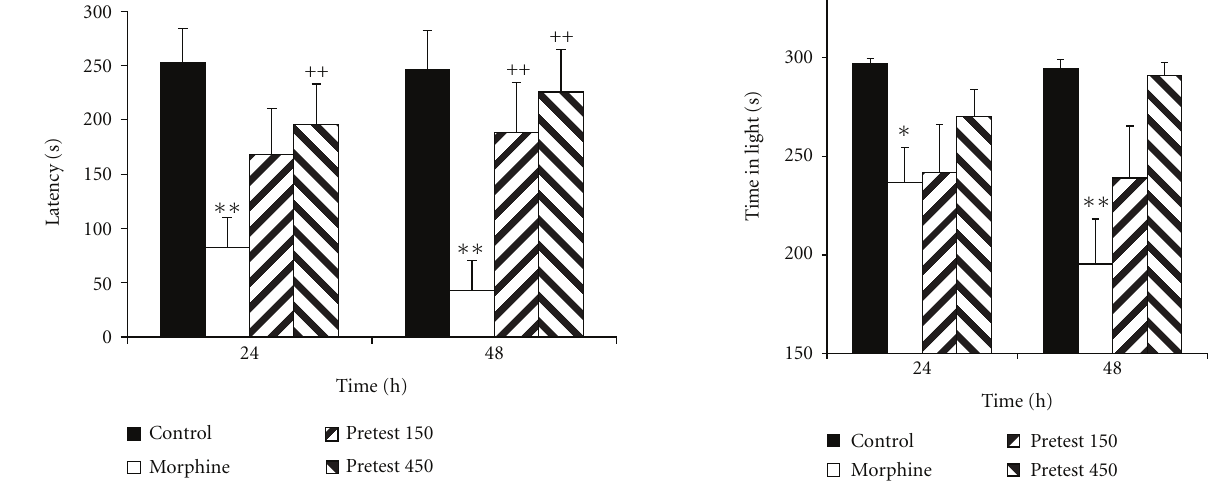
Figure 6: Comparison of the total time spent in the light compartment 24 and 48 h after receiving the shock between the groups. The animals of the control group received saline instead of both sa ff ron extract and morphine. The animals of morphine group were treated by saline instead of SE but received morphine (5mg/kg, s.c.) 30min before the training phase. Pretest 150 and pretest 450 groups were treated by 150 and 450 mg/kg of SE (i.p.), respectively, before the recall phase. The data were presented as mean ± SEM of the total time spent in the light compartment (8 animals in each